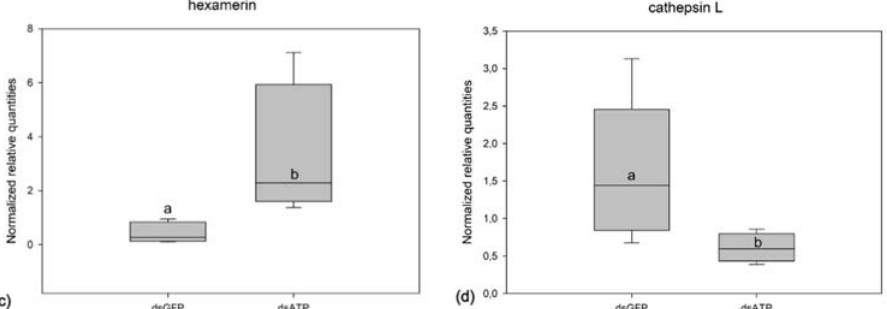
Figure 4. Transcript level of ATP synthase β ( a ), vitellogenin ( b ), hexamerin ( c ), and cathepsin L ( d ) in Scaphoideus titanus females (remaining parts of body after dissection of ovaries observed in Figure 3) sampled at 20 days post injection of dsRNAs targeting green fluorescent protein (GFP) or ATP synthase β (St_dsATP1). Different letters indicate significant differences in transcript levels. The median of four to nine samples is shown as a line across each box, the box indicates the 25th and 75th percentiles and whiskers represent the 90th and 10th percentiles.